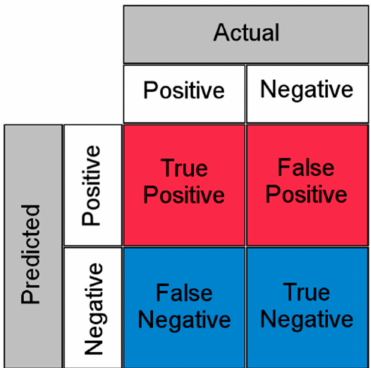
Figure 19. A binary or double-class confusion matrix